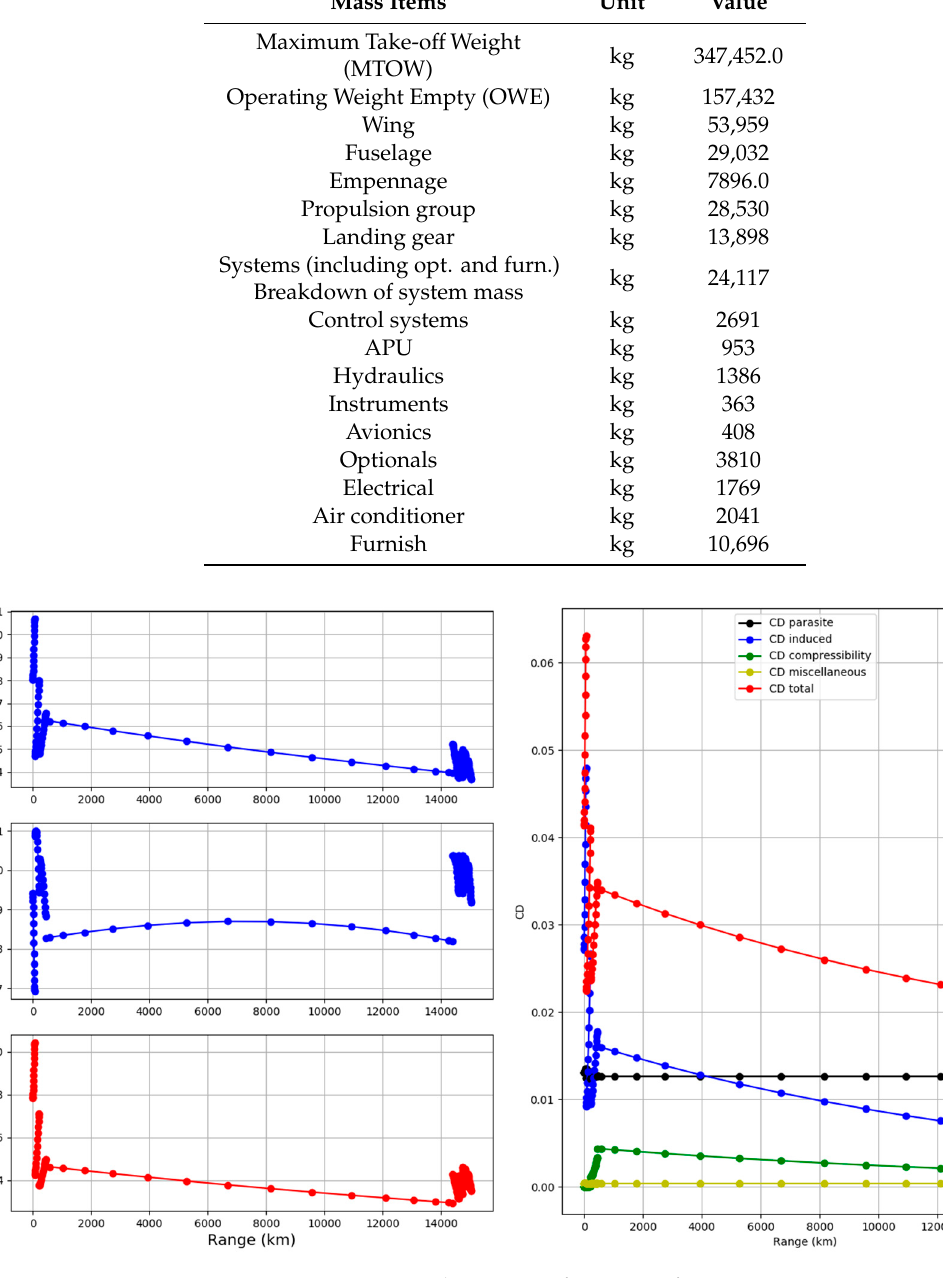
Table A1. Weight break-down of B777 calculated using SUAVE.